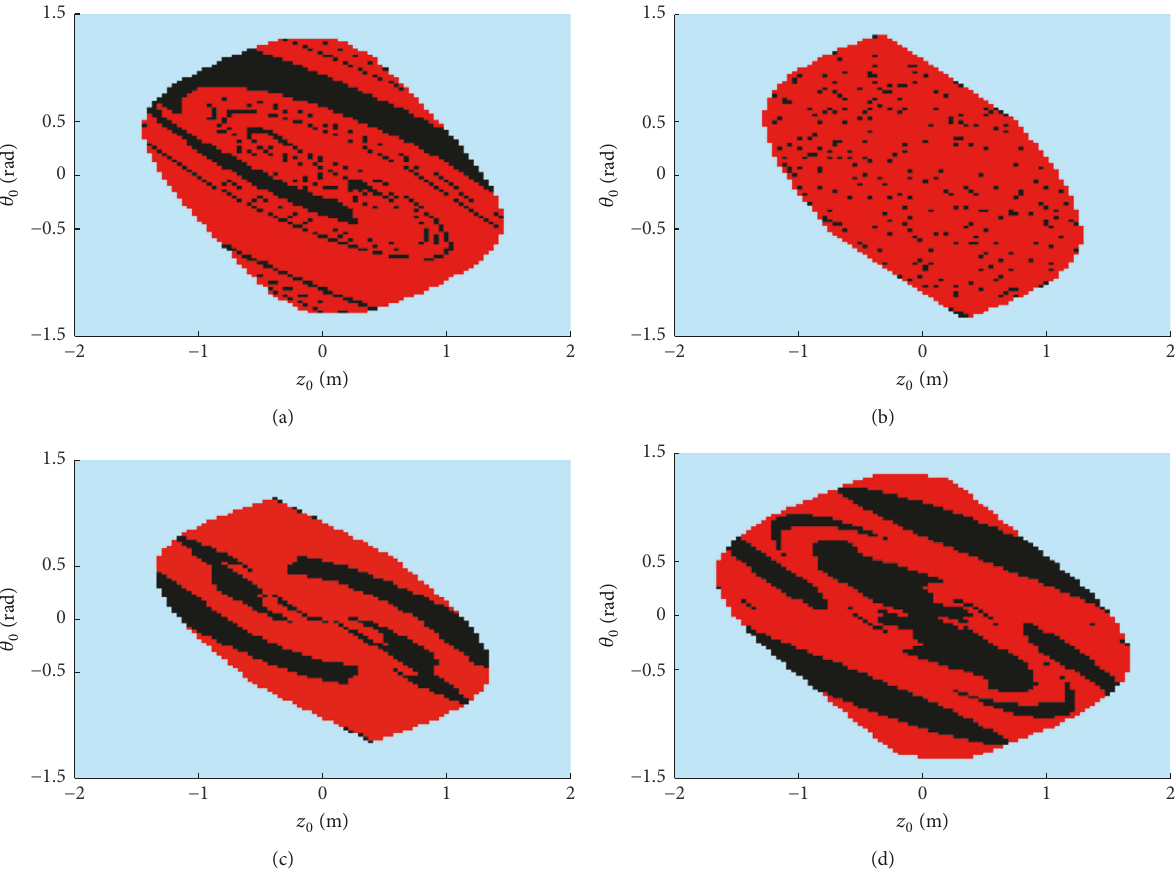
Figure 7: Basins of attraction: (a) 𝜎 = 0.02838 , 𝑘 = −59.01 ; (b) 𝜎 = 0.03136 , 𝑘 = −67.44 ; (c) 𝜎 = 0.03238 , 𝑘 = −62.63 ; (d) 𝜎 = 0.03259 , 𝑘 = −56.04